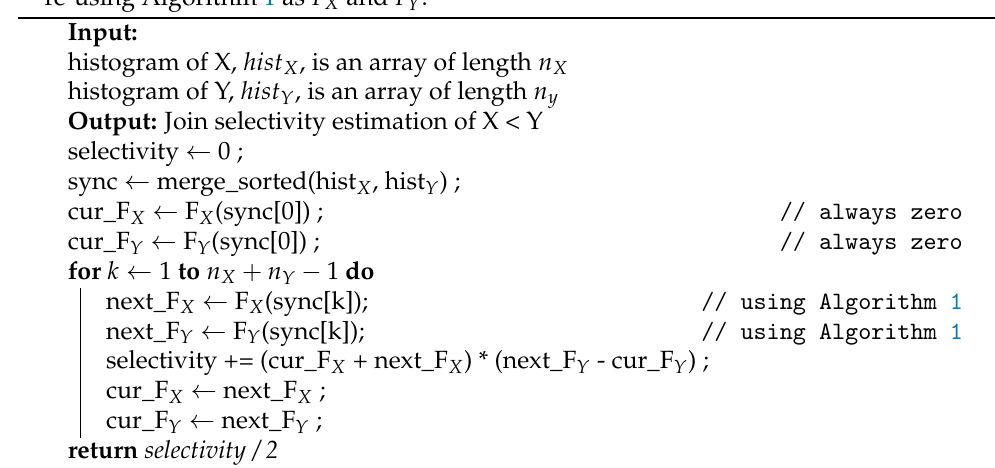
Algorithm 2: Join selectivity estimation algorithm for the less than (<) operator re-using Algorithm 1 as F X and F Y